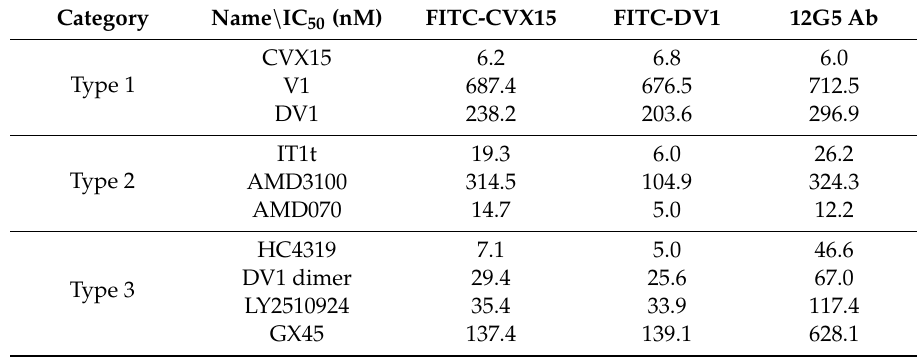
Table 1. Summary on biological a ffi nities (presented by IC 50 values) of diverse CXCR4 ligands in